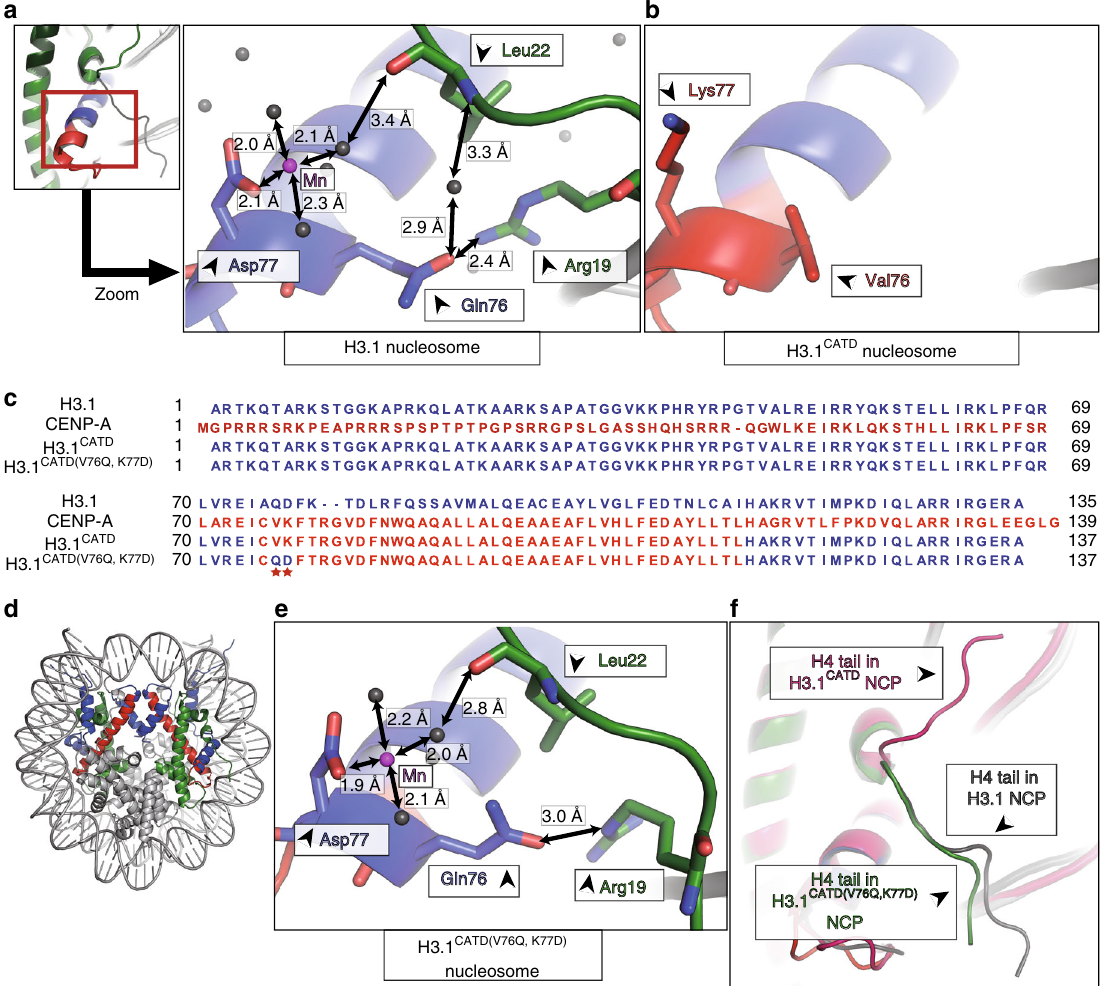
Fig. 2 The human CATD residues Val76 and Lys77 do not bind to the H4 N-terminal tail. a Close-up view of the region around the positions of the Q76 and D77 residues of H3.1 in the nucleosome 76 (PDB ID: 5Y0C). The H3.1 Q76 and D77 residues interact with the H4 R19 (side chain) and L22 (backbone) residues, respectively. Possible hydrogen bonds are presented as arrows. b Close-up view of the region around the positions of the V76 and K77 residues of CATD in the nucleosome. The CATD V76 and K77 residues do not interact with the H4 residues. c Alignment of the amino acid sequences of human histone H3.1, CENP-A, H3.1 CATD , and H3.1 CATD(V76Q, K77D) . Amino acid residues derived from H3.1 and CENP-A are colored blue and red, respectively. Stars indicate the positions of the CATD V76 and K77 residues. d The crystal structure of the nucleosome containing the H3.1 CATD(V76Q, K77D) . The H3.1 CATD(V76Q, K77D) regions derived from H3.1 and CENP-A are colored blue and red, respectively. H4 is colored green. H2A, H2B, and DNA are colored gray. e Close-up view of the region around the positions of the Q76 and D77 residues of H3.1 CATD(V76Q, K77D) in the H3.1 CATD(V76Q, K77D) nucleosome. The H3.1 CATD(V76Q,K77D) Q76 and D77 residues interact with the H4 R19 (side chain) and L22 (backbone) residues, respectively. Possible hydrogen bonds are presented as arrows. f Structural comparison of the H4 N-terminal tails between the H3.1 CATD(V76Q, K77D) nucleosome, the H3.1 CATD nucleosome, and the H3.1 nucleosome 76 (PDB ID: 5Y0C). The H4 N-terminal tails in the H3.1 CATD(V76Q, K77D) nucleosome, the H3.1 CATD nucleosome, and the H3.1 nucleosome are colored green, pink, and gray,